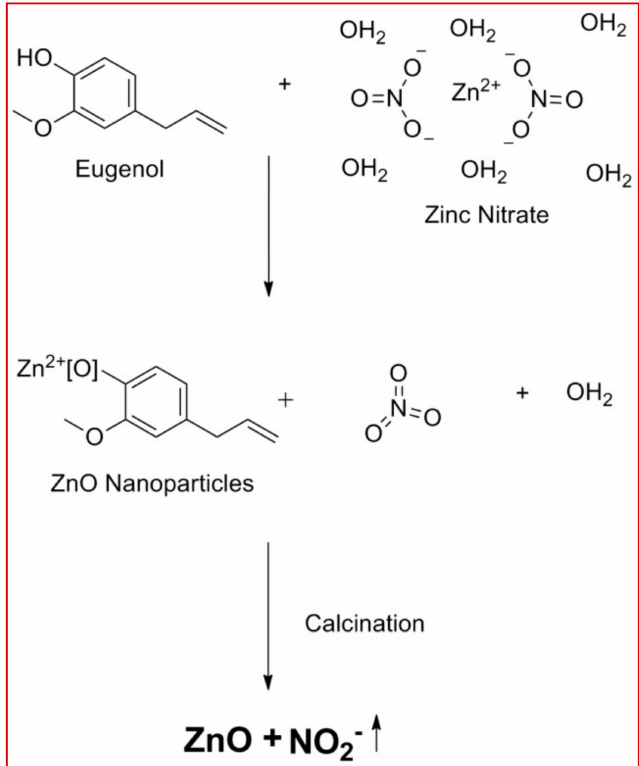
Figure 1. The plausible mechanism involved during the formation of zinc oxide (ZnO)-nanoparticles (NPs) from the bark extract of C.